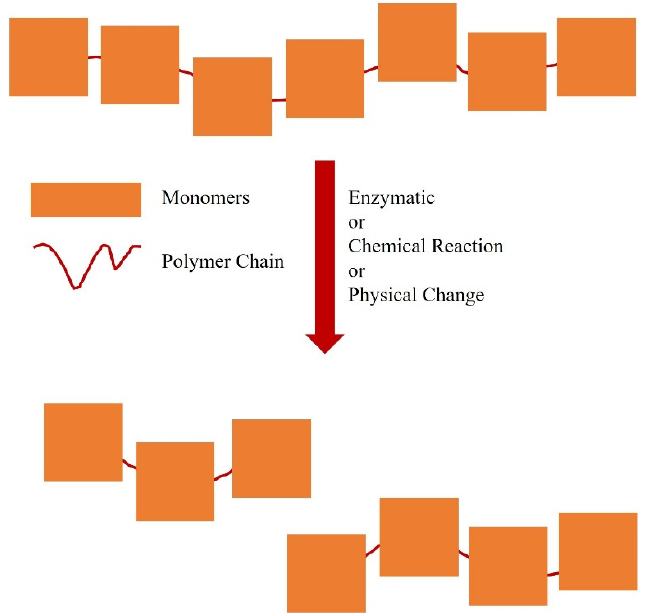
Figure 2. Some synthetic strategies to produce an oligomer from a polymer.